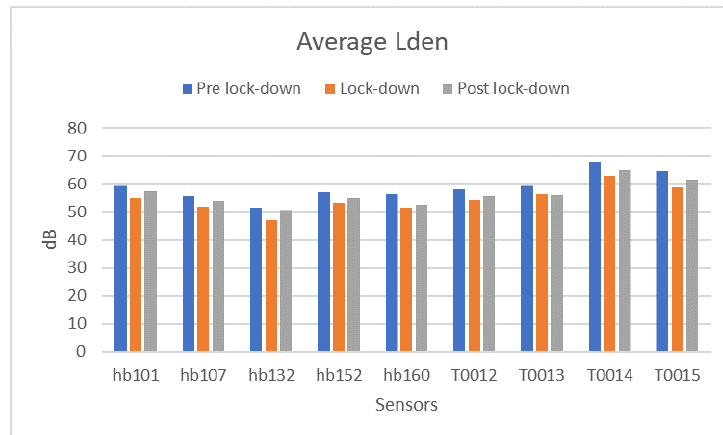
Figure 11: Average Lden for periods before, during and after lock down